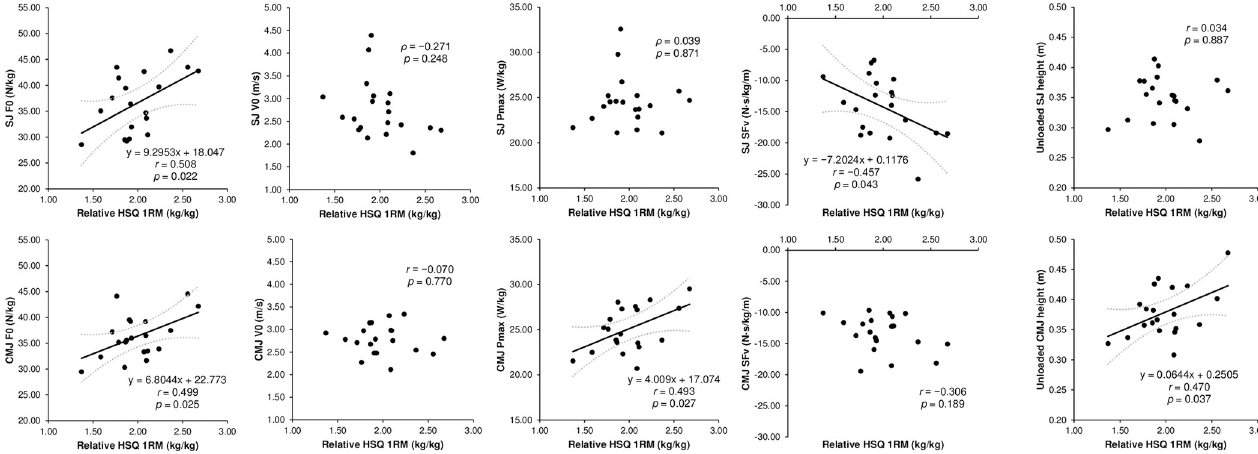
Fig 1. Associations (line-of-best-fit ± 95% confidence intervals) of the maximum strength (relative half squat [HSQ] one-repetition maximum [RM]) with the parameters of the force–velocity (F–v) profiles obtained from the squat jump (SJ) and countermovement jump (CMJ) and with the unloaded SJ and CMJ height. F0 = theoretical maximum force; V0 = theoretical maximum velocity; Pmax = theoretical maximum power; SFv = slope of the linear F–v